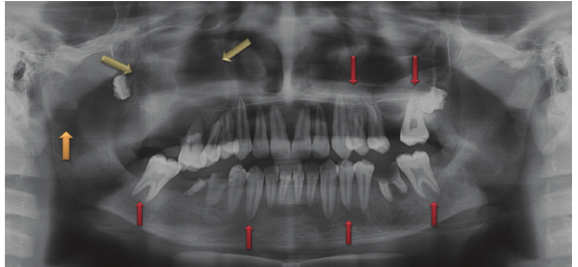
Figure 3: Preoperative radiograph represents multilocular radiolu- cency of maxilla, generalised loss of lamina dura, and unilocular radiolucency in condylar